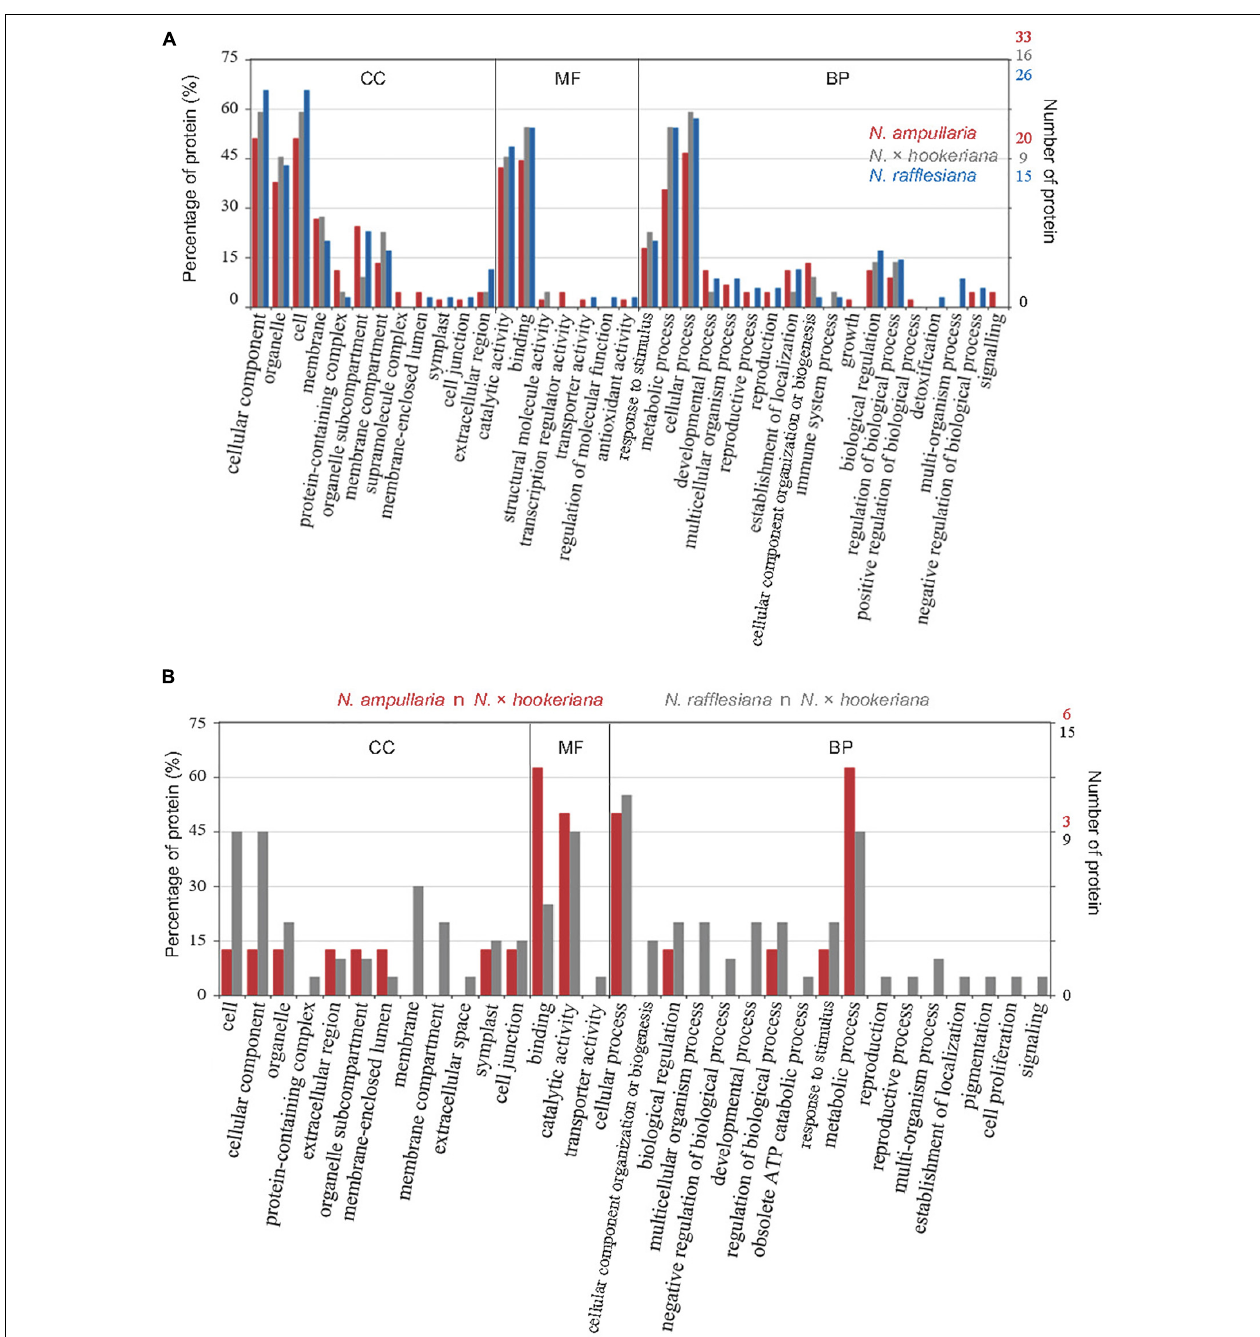
FIGURE 4 | GO distribution of identified proteins from proteomics analysis based on cellular component (CC), molecular function (MF), and biological process (BP). (A) Distribution of GO terms shared among all Nepenthes species. (B) Distribution of GO terms shared between parent and hybrid species, that is, N. ampullaria vs. N. × hookeriana (red), and N. rafflesiana vs. N. × hookeriana (gray).